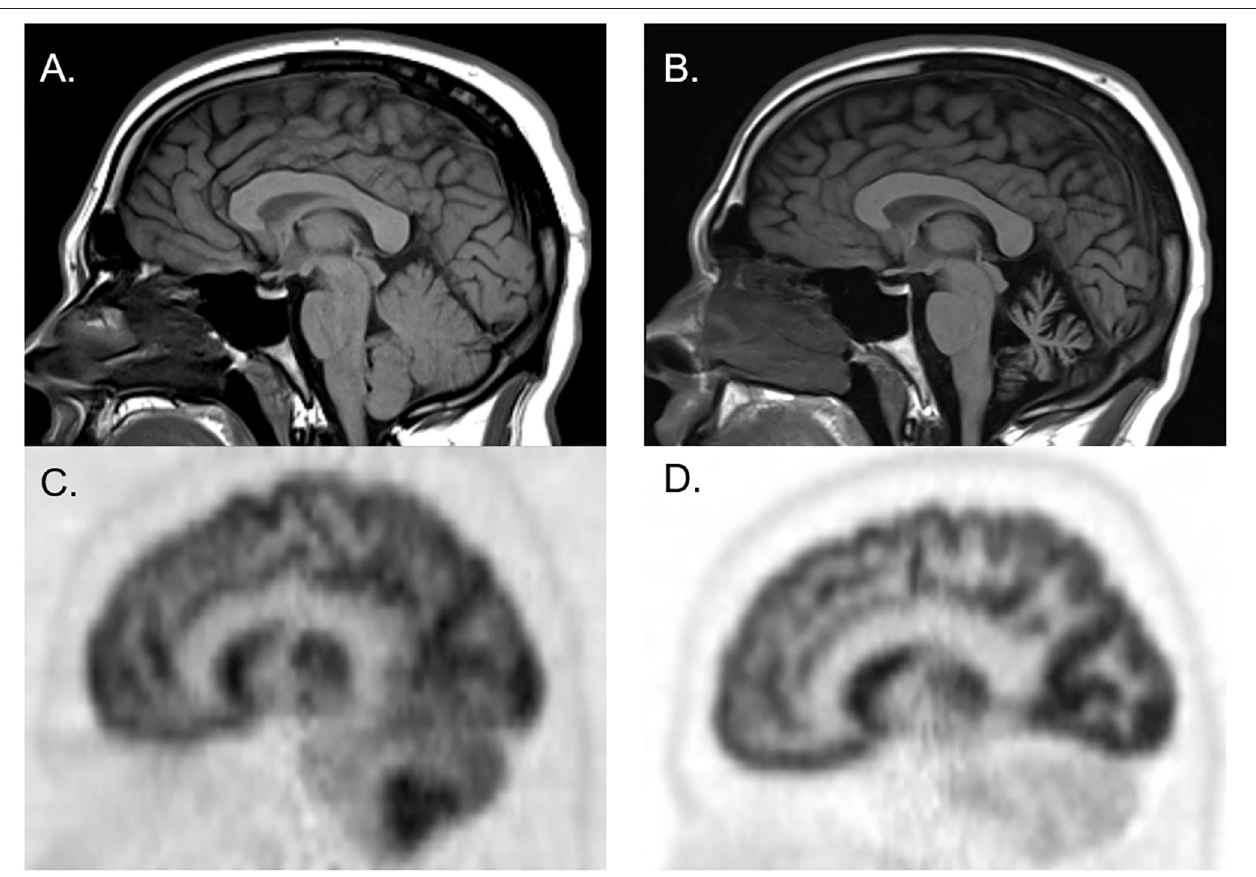
FIGURE 2 | Brain MRI and FDG-PET CT of a man who initially presented with cerebellar ataxia with elevated serum anti-glutamic acid decarboxylase-65 antibodies. At initial presentation, brain MRI was normal [ (A) sagittal], whereas brain FDG-PET showed hypermetabolism of cerebellar hemispheres [ (C) sagittal]. Three years later, follow-up brain MRI showed marked cerebellar atrophy [ (B) sagittal], and brain FDG-PET showed hypometabolism of cerebellar hemispheres [ (D)